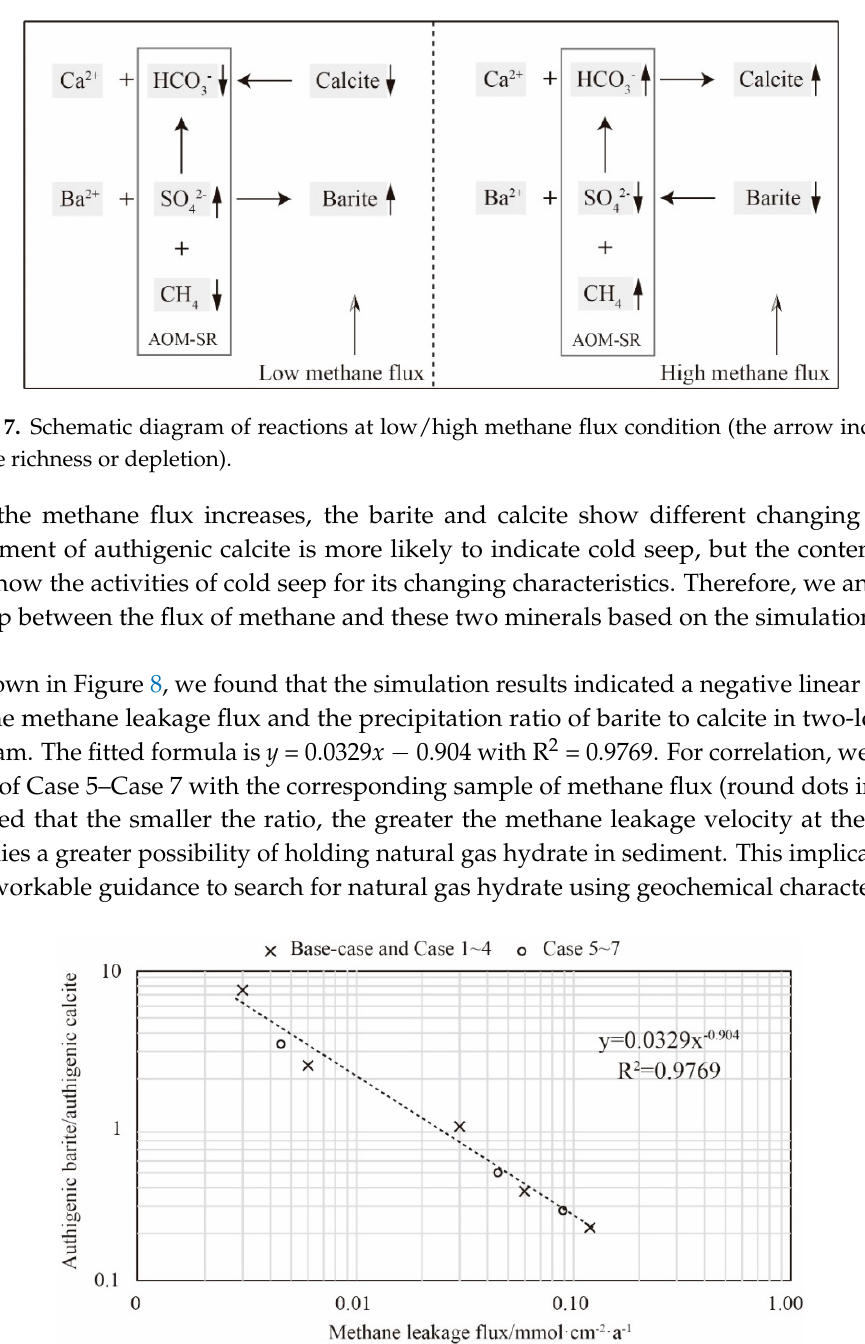
Figure 6. Relationship between methane leakage flux and authigenic minerals. ( a ) Location of Barite front with flux. ( b ) Volume fraction change of barite. ( c ) Volume fraction change of calcite.